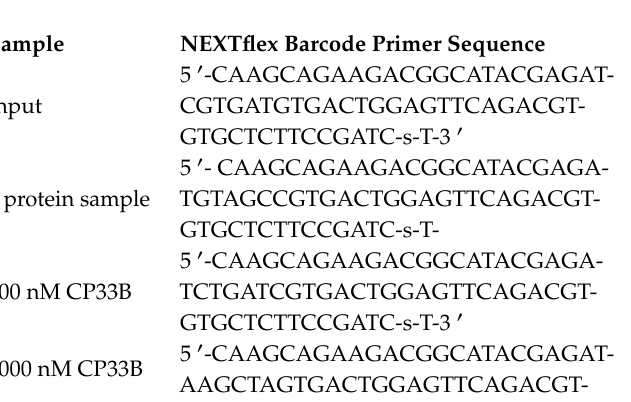
Figure S1: Details of CP33B oligo-RIP-chip analysis, Table S1: RIP-Chip data for Fig. 3a, Table S2: Oligo RIP-Chip data for Fig. 3b and Fig. S1, Table S3: summary of sites in the chloroplast genome of Arabidopsis that correspond to the top motif of the RBNS analysis, Table S4: RIP-chip data for Fig. 5B (CP33B RIP-chip from